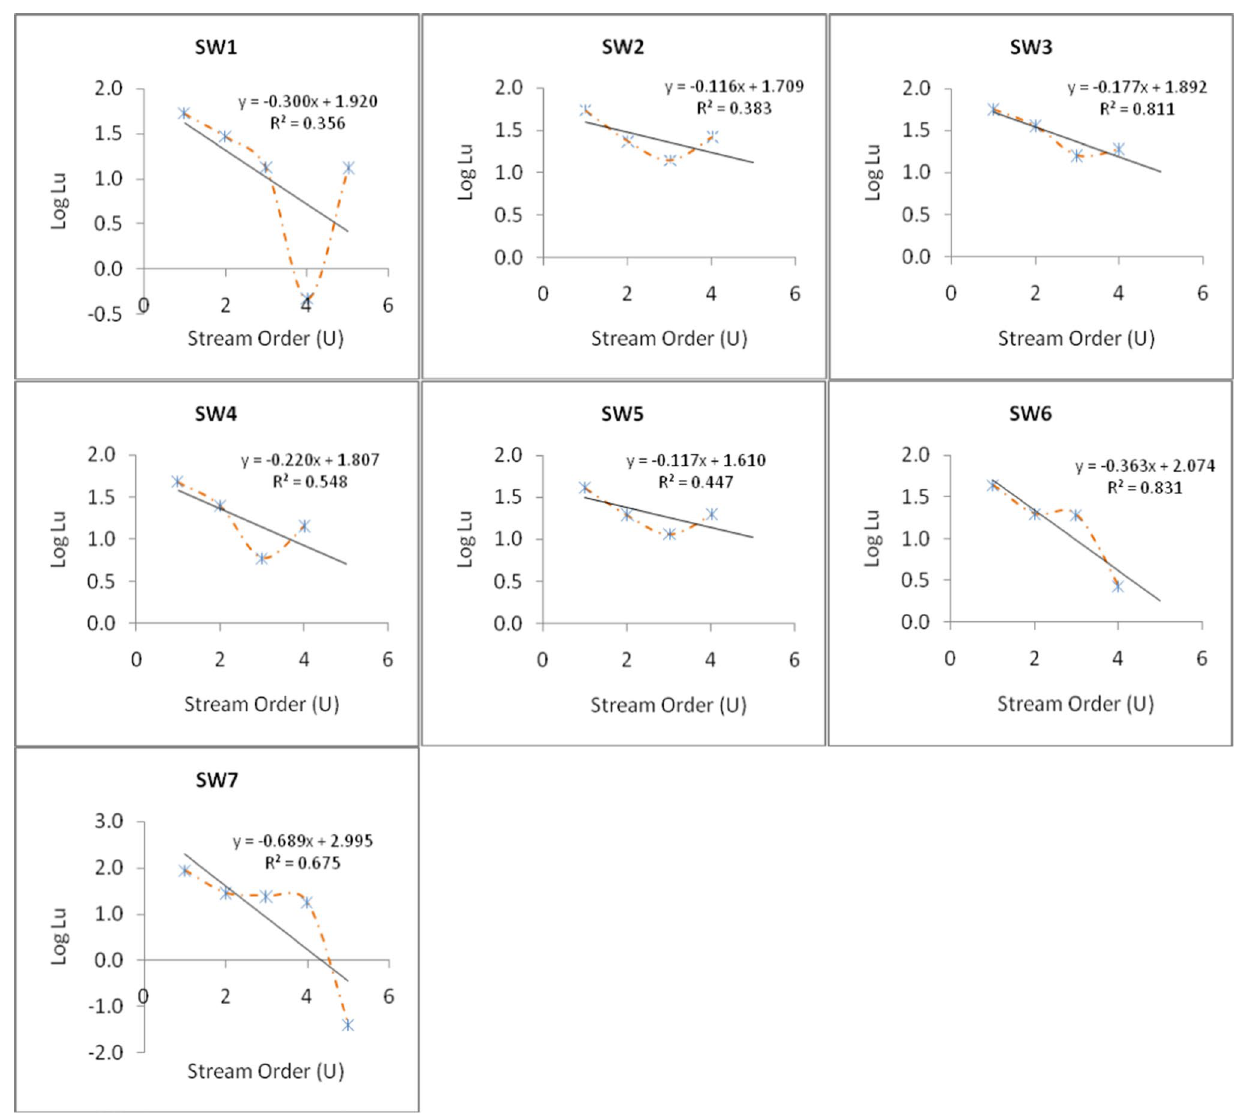
Fig. 5 The relationship between stream order and stream